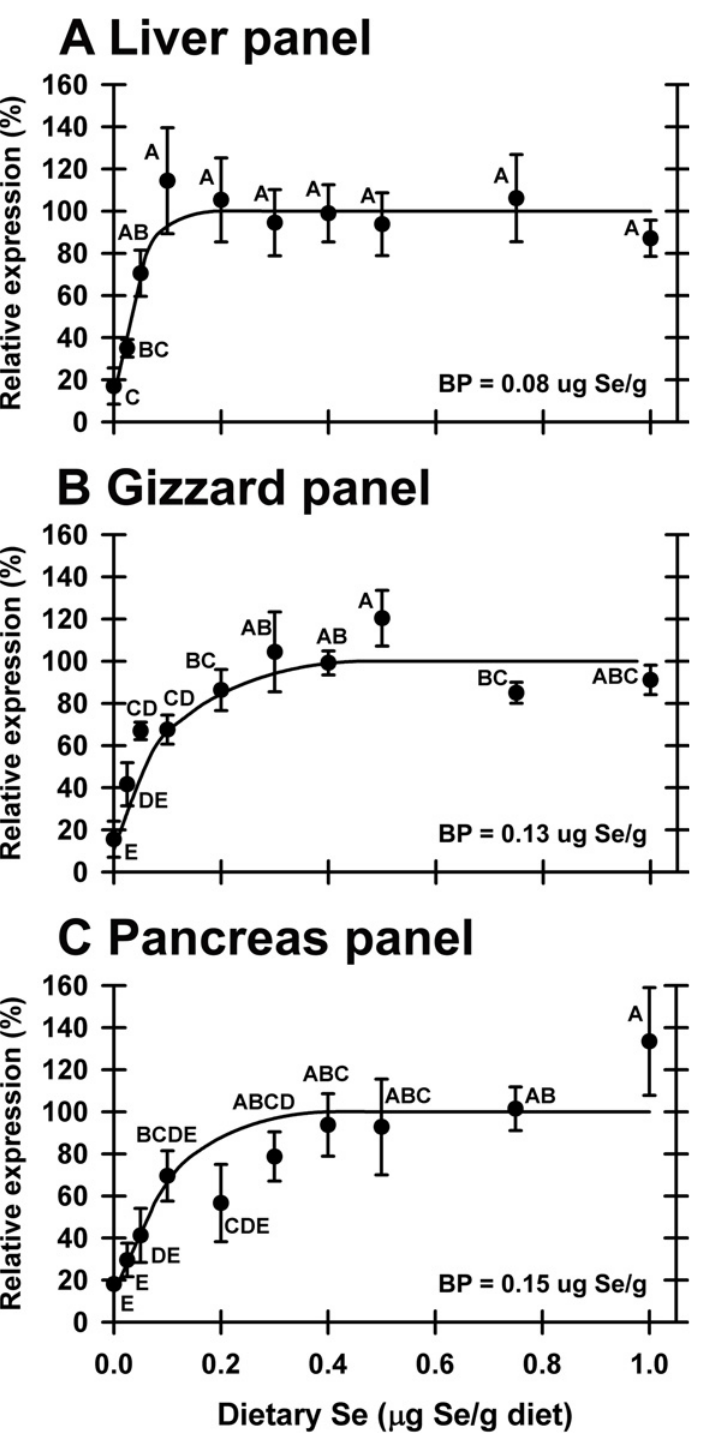
Fig 7. Effect of dietary Se on selenoprotein transcript panels in liver (A), gizzard (B) and pancreas (C). Within a tissue, the individual relative transcript levels for each significantly-regulated selenoprotein were averaged to determine panel values, which were then subjected to the Se-response curve analysis described in the text. Resulting mean ± SEM are plotted, and means without a common letter are significantly different ( P < 0.05). Overall level of significance, as determined by ANOVA, is given in Table 2. Se-response curve breakpoints (BP) are indicated in each panel, calculated as described in